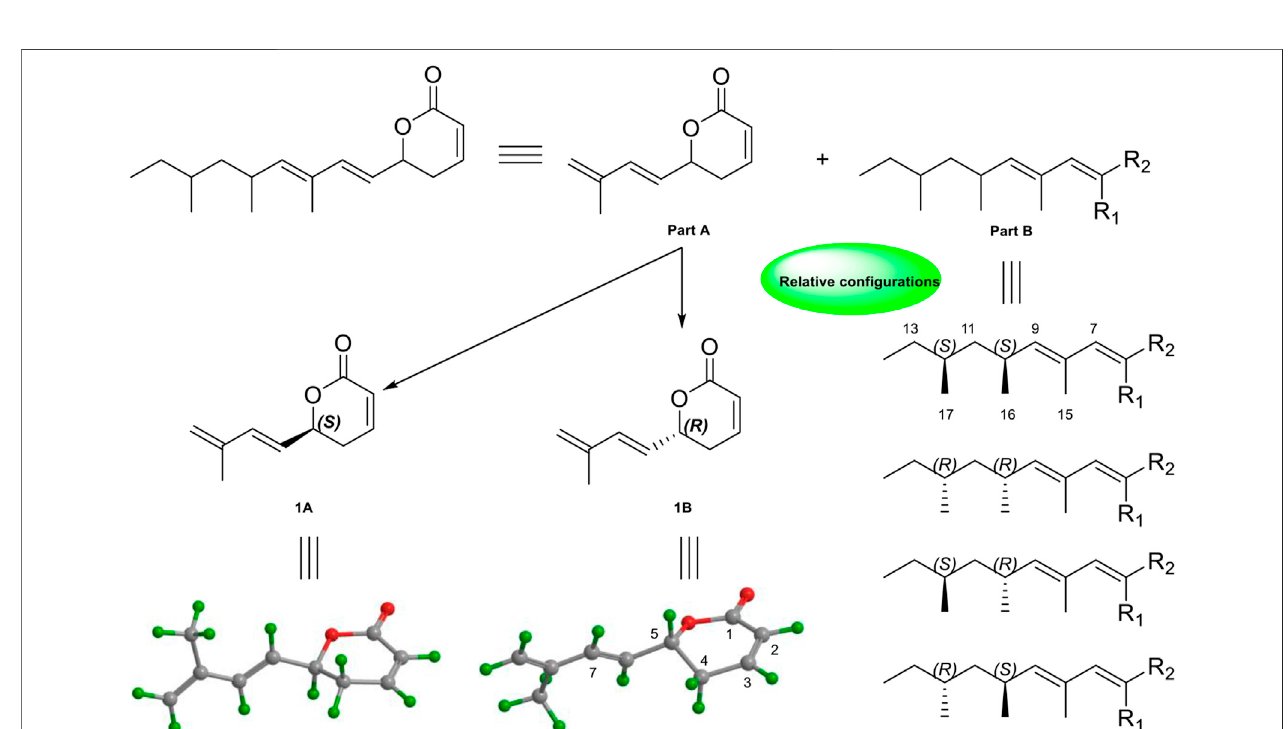
FIGURE 3 | Key NOESY correlations and relative con fi gurations of compound 1.